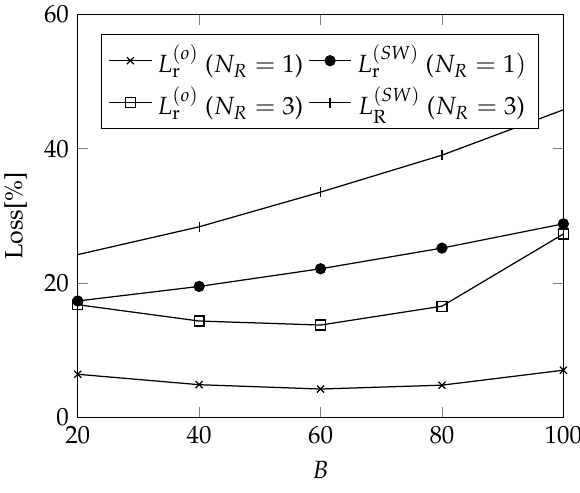
Figure 3. MVNO’s